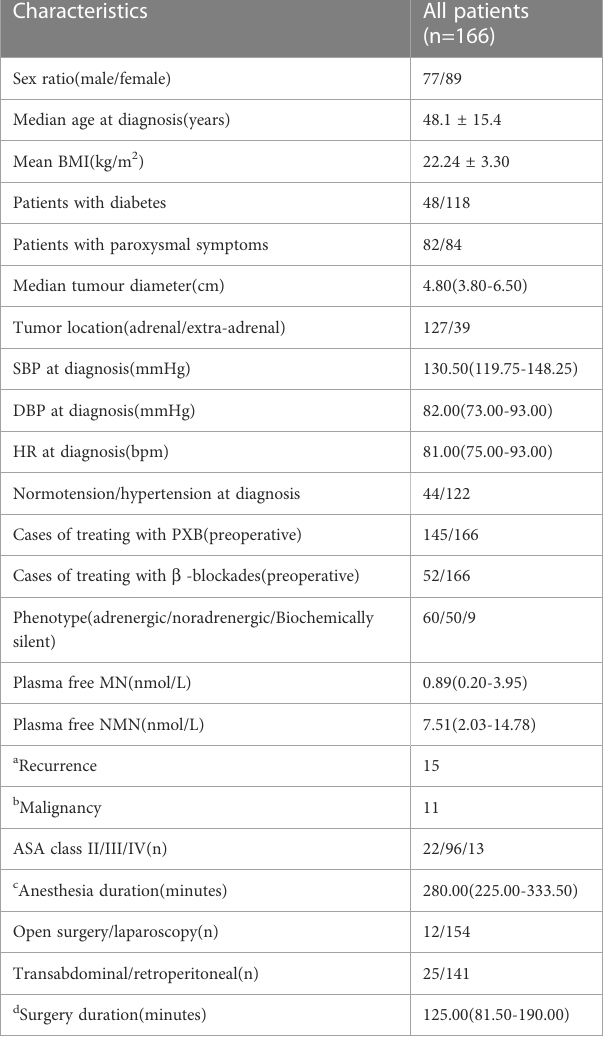
TABLE 1 General characteristics of 166 patients operated on for pheochromocytoma or paraganglioma.